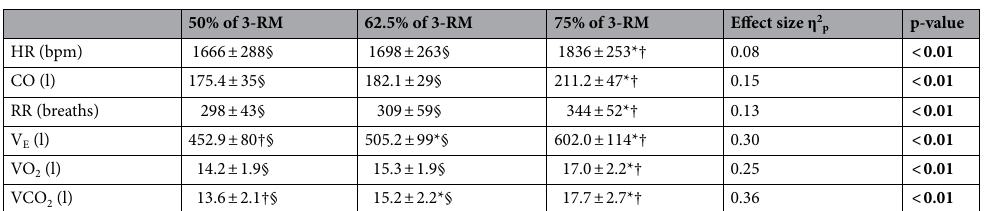
Table 4. Cumulated values during exercise and resting periods (three sets of 10 repetitions squats) and recovery periods (three × 4 min after exercise) (n = 14). Significant values are in bold. Values are presented as the means and standard deviation; 3‑RM three repetition maximum, η 2 p partial eta-squared of the one-way repeated measures ANOVA, HR heart rate, CO cardiac output, RR respiratory rate, V E ventilation, VO 2 oxygen uptake, VCO 2 carbon dioxide output; * (P < 0.05) different from 50% intensity; † (P < 0.05) different from 62.5% intensity; § (P < 0.05) different from 75% intensity.